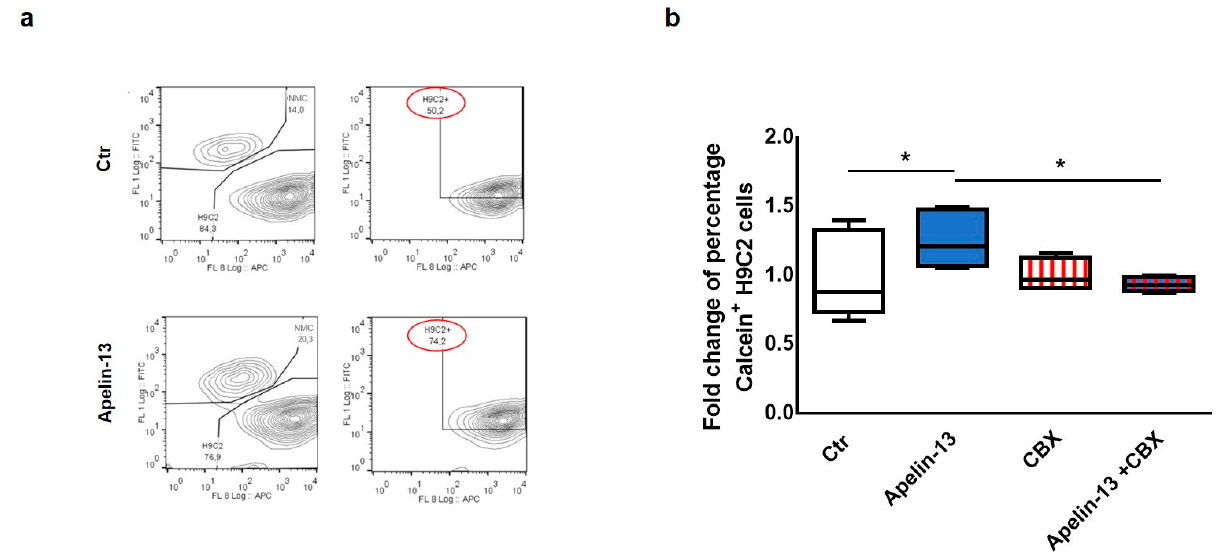
Figure 2. Apelin-13 treatment augments intercellular communication through gap junctions. ( a ) Representative dye transfer experiment in flow cytometry. Upper panel: H9C2 cells labelled with Did dye (APC) were cultured for 24 h with control NMCs labelled with Calcein-AM (FITC). Lower panel: H9C2 cells were cultured for 24 h with NMCs treated with Apelin-13 and labelled with Calcein-AM. After coculture, H9C2 cells double-positive (APC+ FITC+) were analysed through flow cytometry; green (FITC+) fluorescence detected in H9C2 cells was due to Calcein-AM they received through intercellular communication with NMCs. ( b ) Dye transfer analysis of H9C2 cells cocultured for 24 h with NMCs treated or untreated with Apelin-13 and in the presence or absence of gap junction inhibitor carbenoxolone (CBX). Before treatment, NMCs were stained with Calcein-AM (gap junction permeant dye), whereas H9C2 cells were stained with Did dye to discriminate the two types of cells. Boxplot shows distribution of fold change of mean fluorescence relative to Calcein + cells. At least 80,000 cells were analysed for each experiment (* p ≤ 0.05; n = 3).